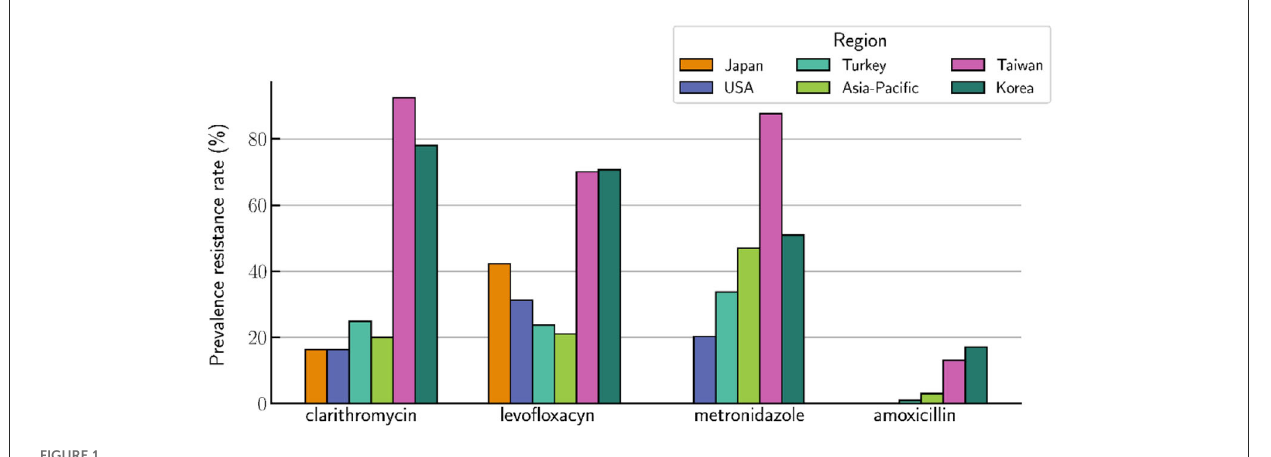
FIGURE1 Prevalence of MDR rate (%) by